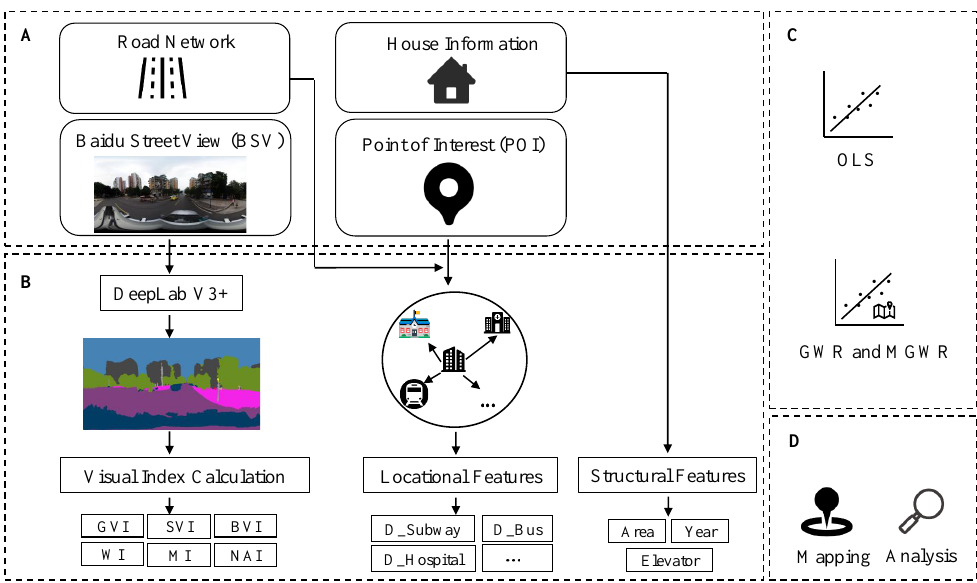
Figure 1. The framework of this study: ( A ) Data collection. ( B ) Feature extraction. ( C ) Model construction. ( D ) Mapping and